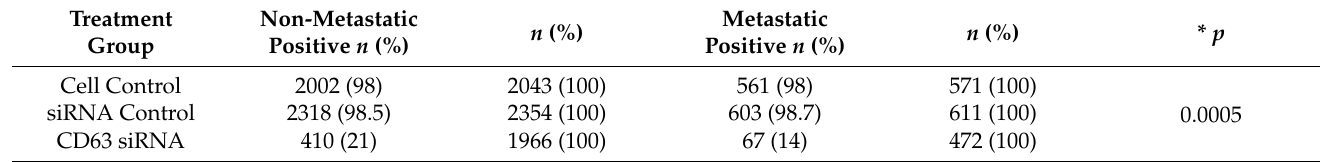
Table 5. Semi-quantitative measurement of CD63 expression in CD63-siRNA transfected and controls by ICC. Treatment